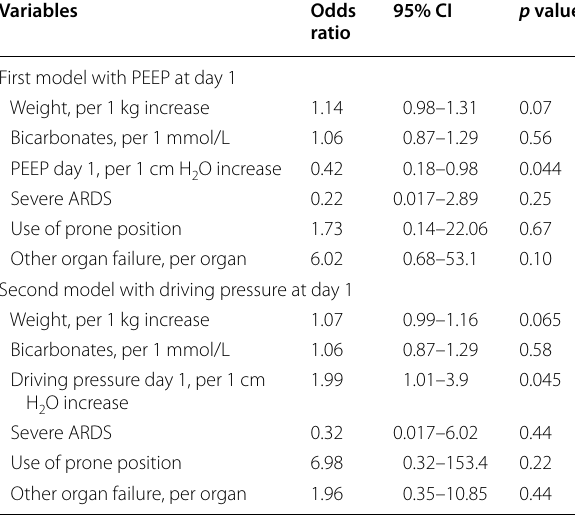
Table 4 Multivariate analysis evaluating the factors asso- ciated with increase(s) in cisatracurium